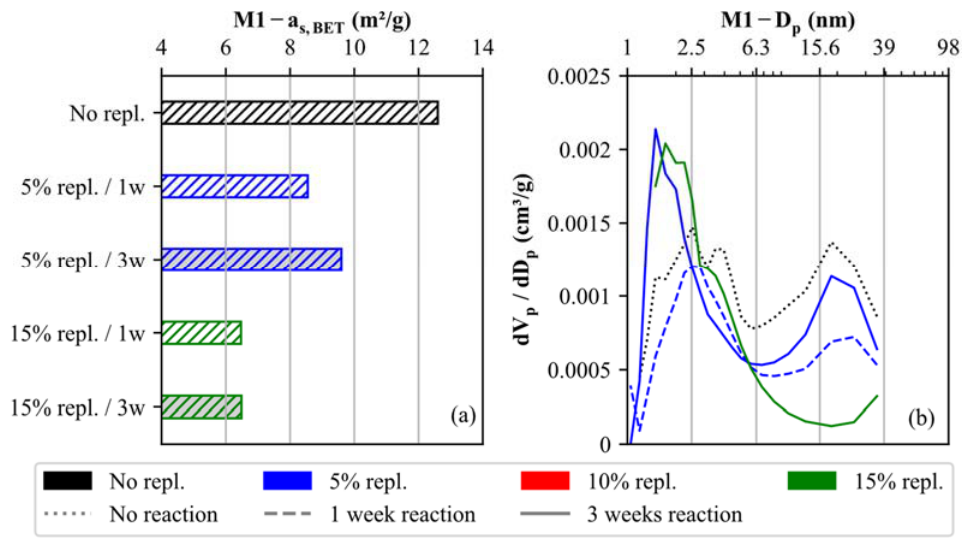
Figure 9. Comparison of ( a ) specific surface areas ( a s,BET ) and ( b ) pore size distributions for uncemented and artificially cemented soil specimens ( M1 ) determined by N 2 ‐ BET physisorption. In addition, the pore size distribution of soil specimens is compared for M1 in Figure 9b. The differential pore area ( dVp/dDp ) varies between 0.0007 and 0.0015 cm³/g for pore sizes ranging from 1.3 to 35 nm. The local maxima are reached at pore sizes equal to 2.5 and 18 nm. This pore size distribution changes as soon as nano ‐ calcite cements are formed. While the number of pore sizes >6 nm decreases, the number of small pores <6 nm